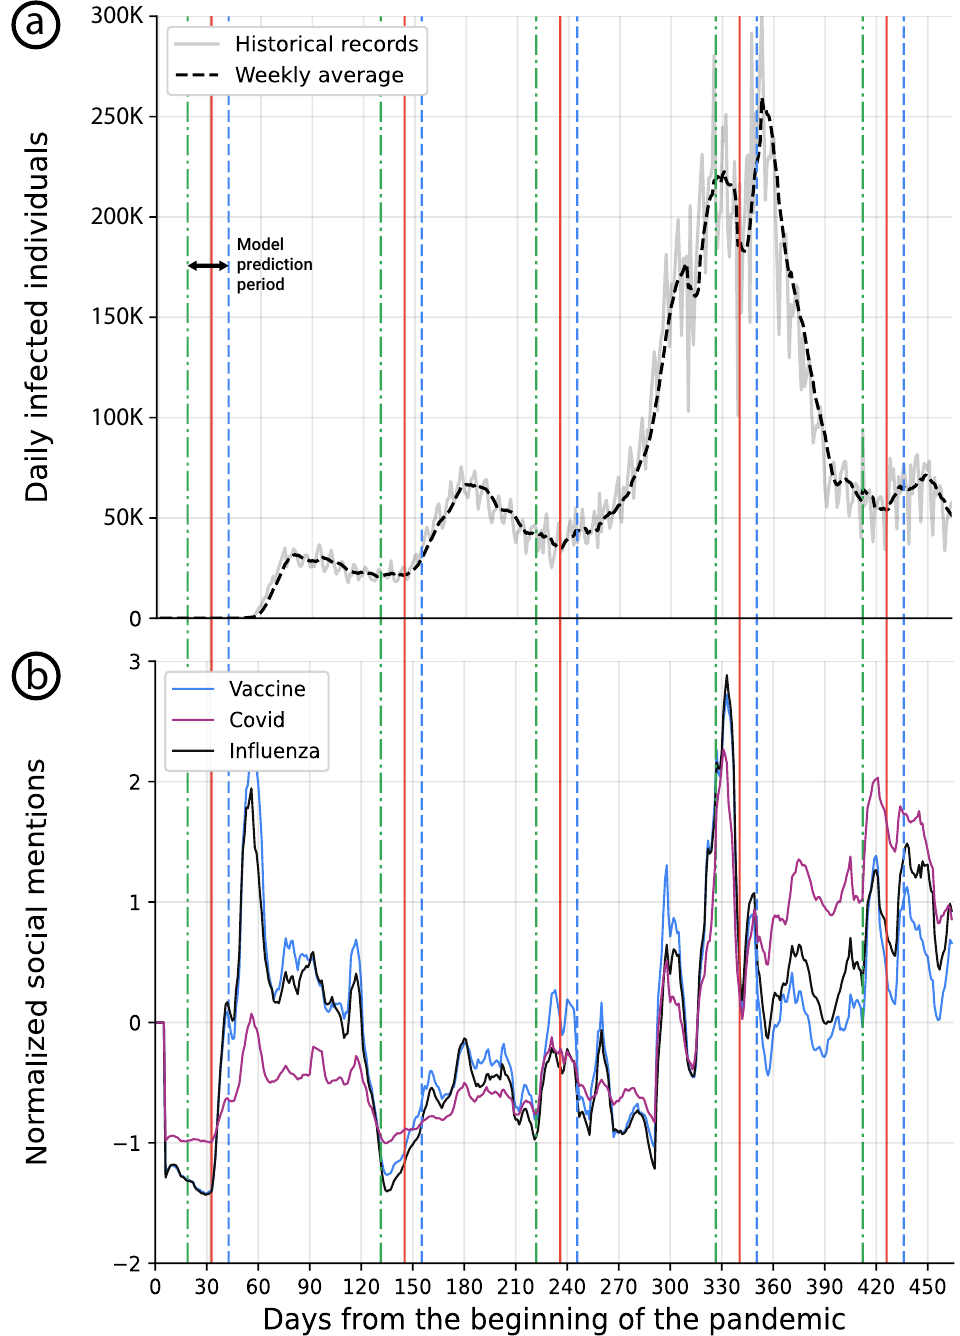
Figure 5. ( a ) the daily official number of infected individuals in the USA is shown in a solid gray line with a weekly moving average line shown in dashed black. ( b ) the weekly average z-score of a normalized number of Twitter posts that were related to the “vaccine”, “covid”, and “influenza” subjects are presented, respectively. The blue dashed line indicates the clinically identified beginning of a wave, the red solid line indicates the retrospective beginning of a wave, and the green dotted line indicates the two-week model’s prediction